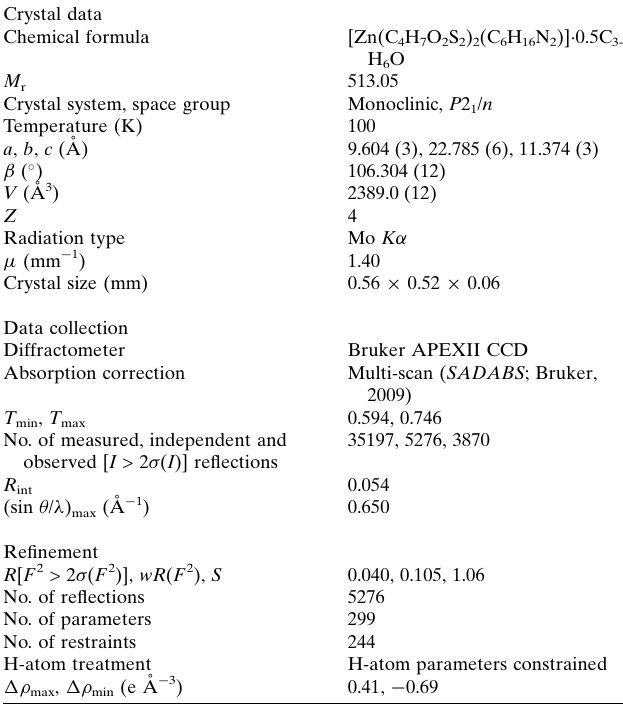
Table 3 Experimental details. Crystal data Chemical